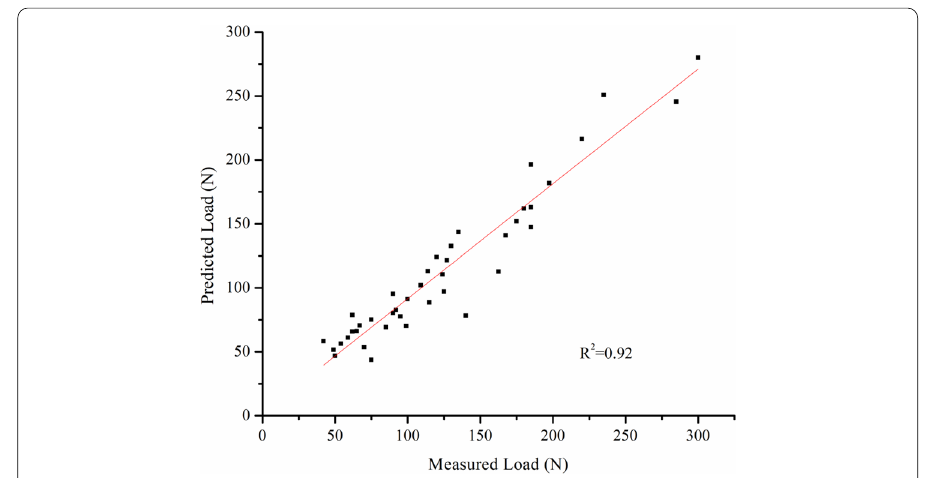
Fig. 12 Scatter plot for Le/L greater than 0.30